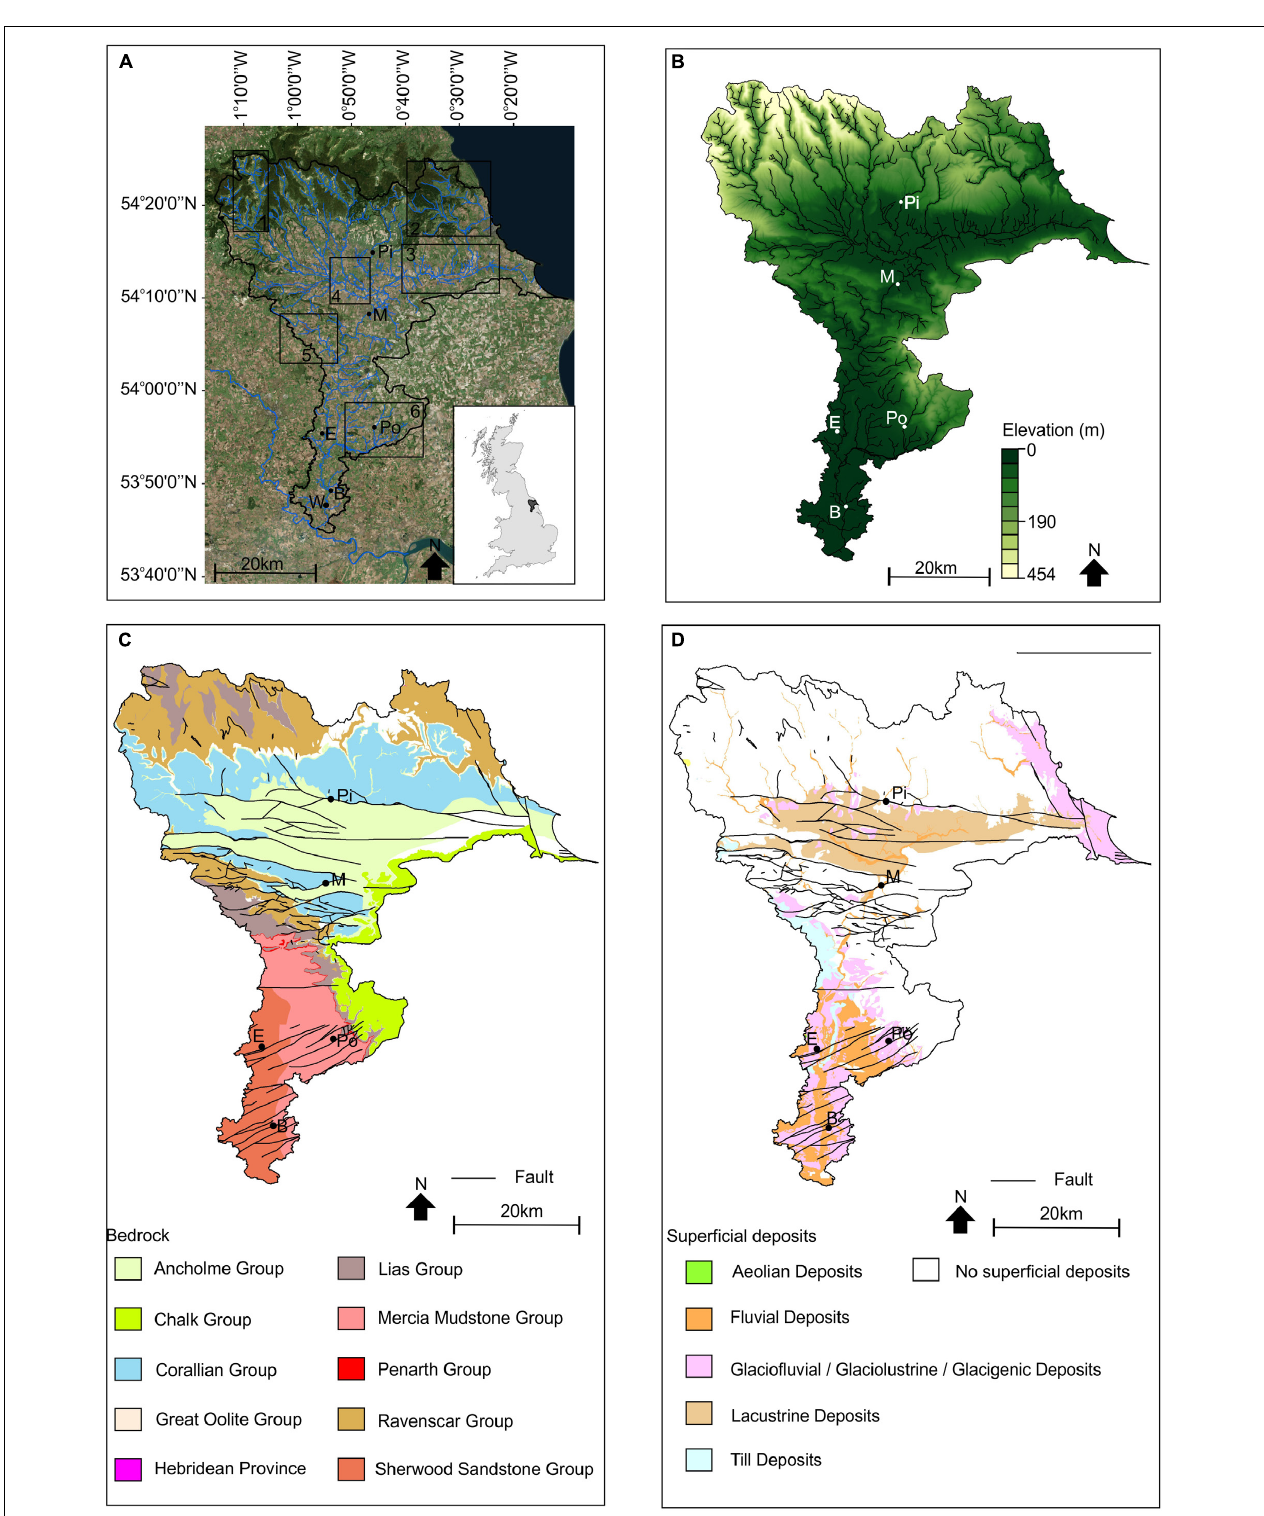
FIGURE 1 | Locations and geological setting of the River Derwent Catchment; (A) Location of catchment. Including the sub-catchment locations for assessing macroinvertebrate data. Locations are shown; Pi, Pickering; M, Malton; Po, Pocklington; E, Elvington; B, Bubwith; and W, Wressel; (B) elevation variation within the catchment, locations shown; (C) bedrock geology and (D) superficial geology. Locations shown for B–D ; Pi, Pickering; M, Malton; Po, Pocklington; E, Elvington; and B, Bubwith.